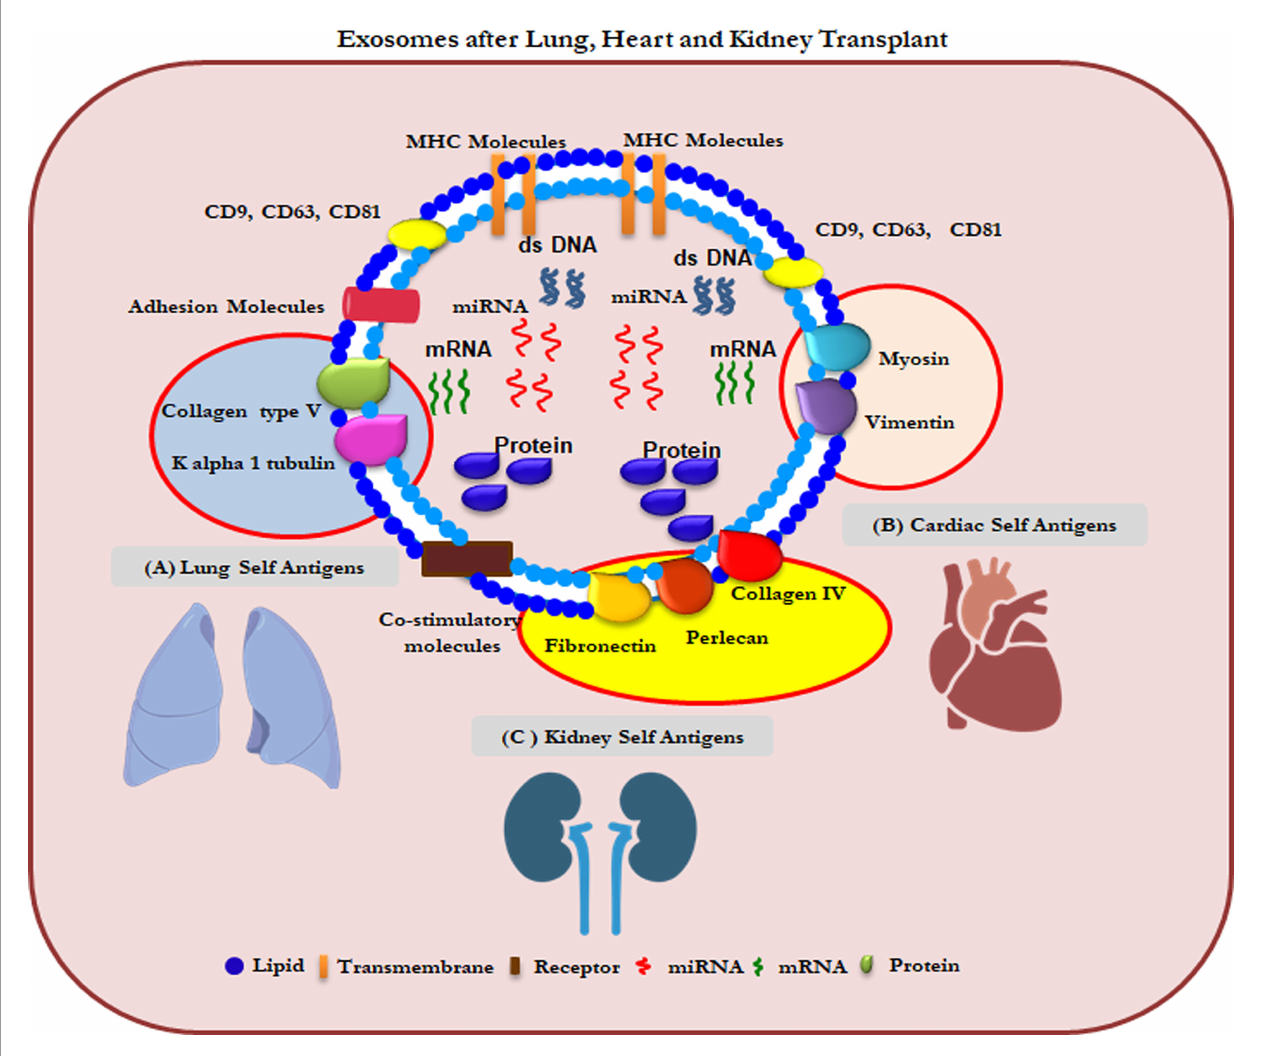
FIGURE 2 | Composition of sEVs from lungs, heart and kidney transplant patients. (A) Col-V and K a 1T TAgs on lung speci fi c sEVs (B) MYO and VIM TAgs on heart speci fi c sEVs (C) Perlecan and Fibronectin TAgs on kidney speci fi c